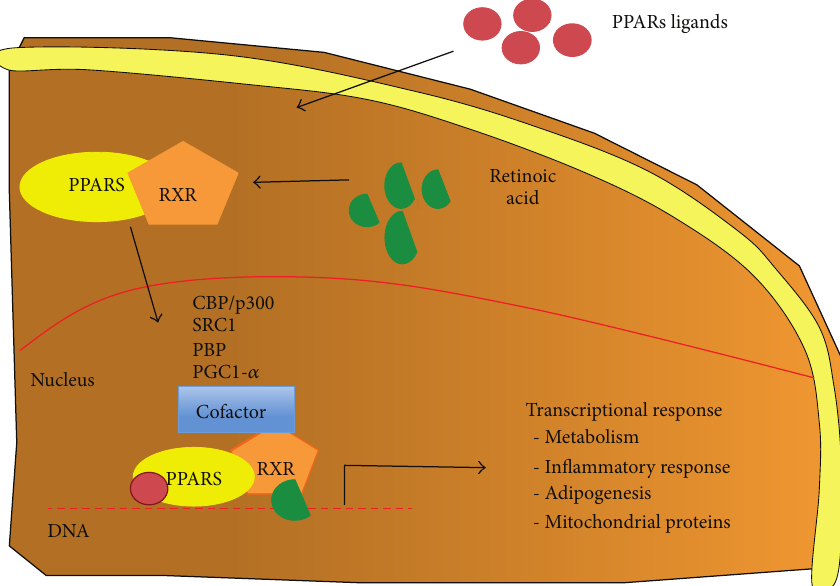
Figure 1: Overview of PPARs signaling and activation . The figure shows how PPARs are activated. PPARs ligand enters the cell where it binds to promote receptor dimerization with receptor of 9-cis-retinoic acid (RXR). This complex migrates to the nucleus where it binds to DNA and to different cofactors proteins (CBP/p300, SRC1, PBP, and PGC1- 𝛼 ), to induce the expression of several genes involved in metabolism, inflammatory response, and antioxidant